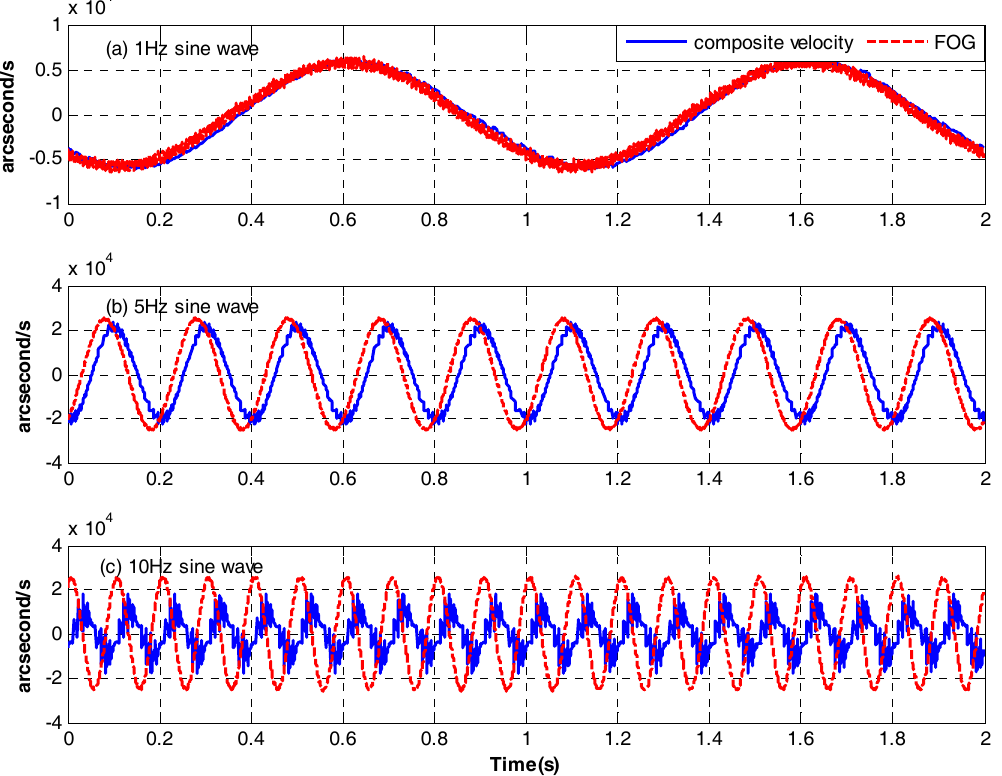
Figure 9. The time-domain curves of the composite velocity and FOG: ( a ) 1 Hz sine wave; ( b ) 5 Hz sine wave; ( c ) 10 Hz sine wave.